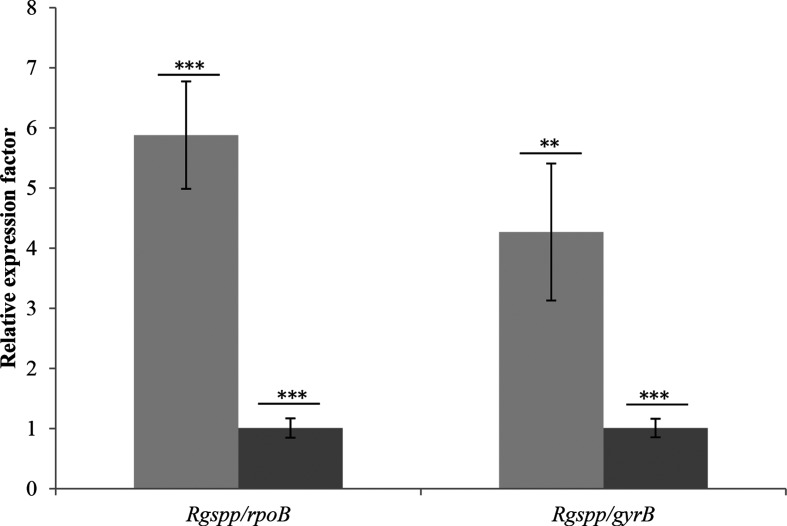
Expression of the RgSPP-encoding gene in monoxenic mice fed with different diets. Dark grey, SD (n=10); light grey, HF diet (n=10). Two different housekeeping genes were used to normalize the experiment, rpoB (left) and gyrB (right). P values were determined using Student's t-test. **, P<0.005; ***, P<0.001.